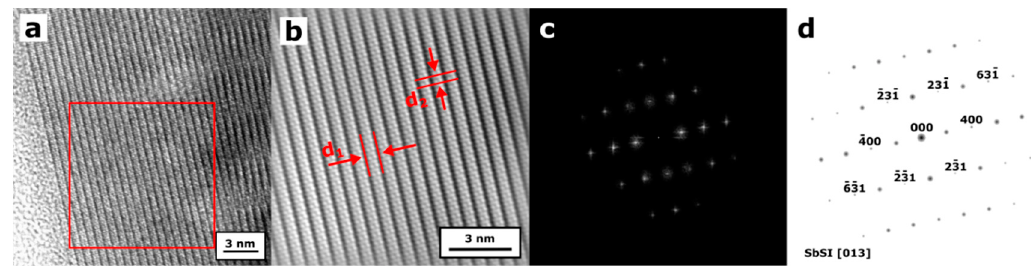
Figure 1. ( a ) Typical high-resolution transmission electron microscopy (HRTEM) micrograph of an individual SbSI nanowire from sonochemically prepared xerogel; ( b ) selected area of HRTEM micrograph marked in ( a ) filtered using fast Fourier transform (FFT) image processing; ( c ) electron diffraction pattern of single SbSI nanowire in the orientation close to the [013] zone axis and ( d ) its simulated diagram; the fringe spacings of d 1 = 0.649 (5) nm and d 2 = 0.414 (4) nm correspond to the interplanar distances of 0.64989 and 0.4160 nm between the (110) and (001) planes of SbSI crystal [48], respectively.